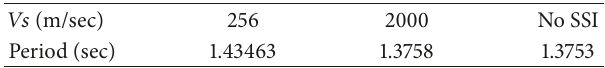
Table 3: The fundamental period of 12-story building for different soil shear wave